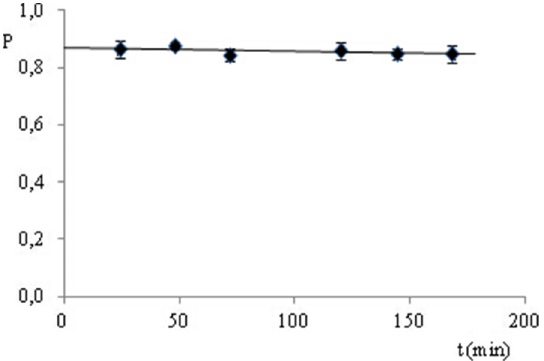
Figure 3. Plot of P as a function of time for a solution of CS (80 μg/mL) stored at room temperature under uncontrolled conditions protected from light.